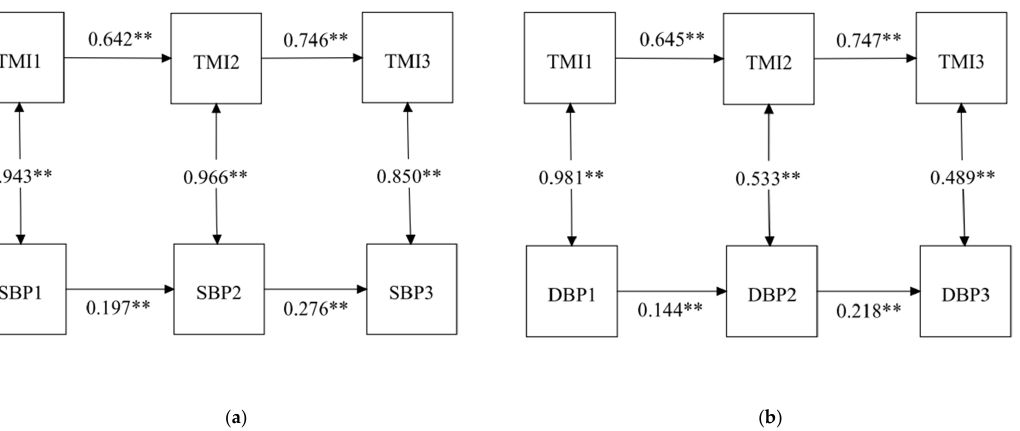
Figure 2. Stability model with TMI and BP among children at three time points: ( a ) stability model with TMI and SBP; ( b ) stability model with TMI and DBP. ** p < 0.001; TMI, tri-ponderal mass index; SBP, systolic blood pressure; DBP, diastolic blood pressure.